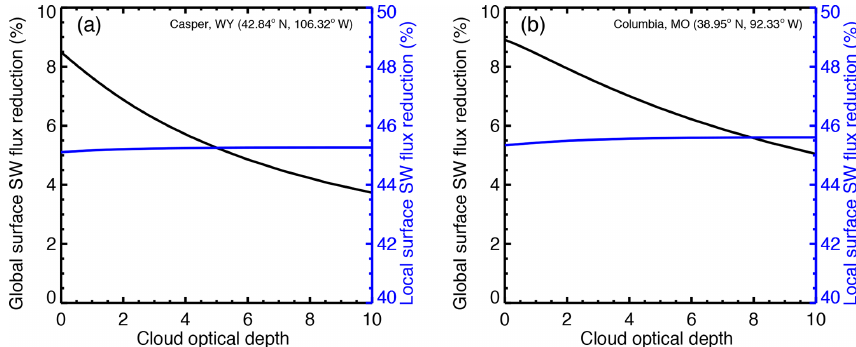
Figure 10. (a) Casper; (b) Columbia. The modeled relative reduction of average local surface flux (blue) during the eclipse and estimated impact on global surface SW flux budget